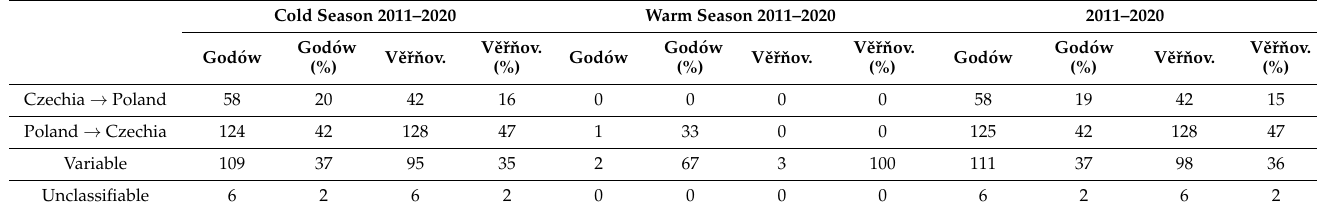
Table 4. Quantification of transboundary PM 10 transmission between the Czech Republic and Poland (number of exceedances of the value of 100 µ g · m − 3 for average daily PM 10 concentrations),